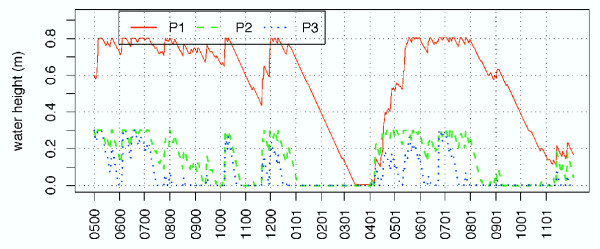
Water height in pools.